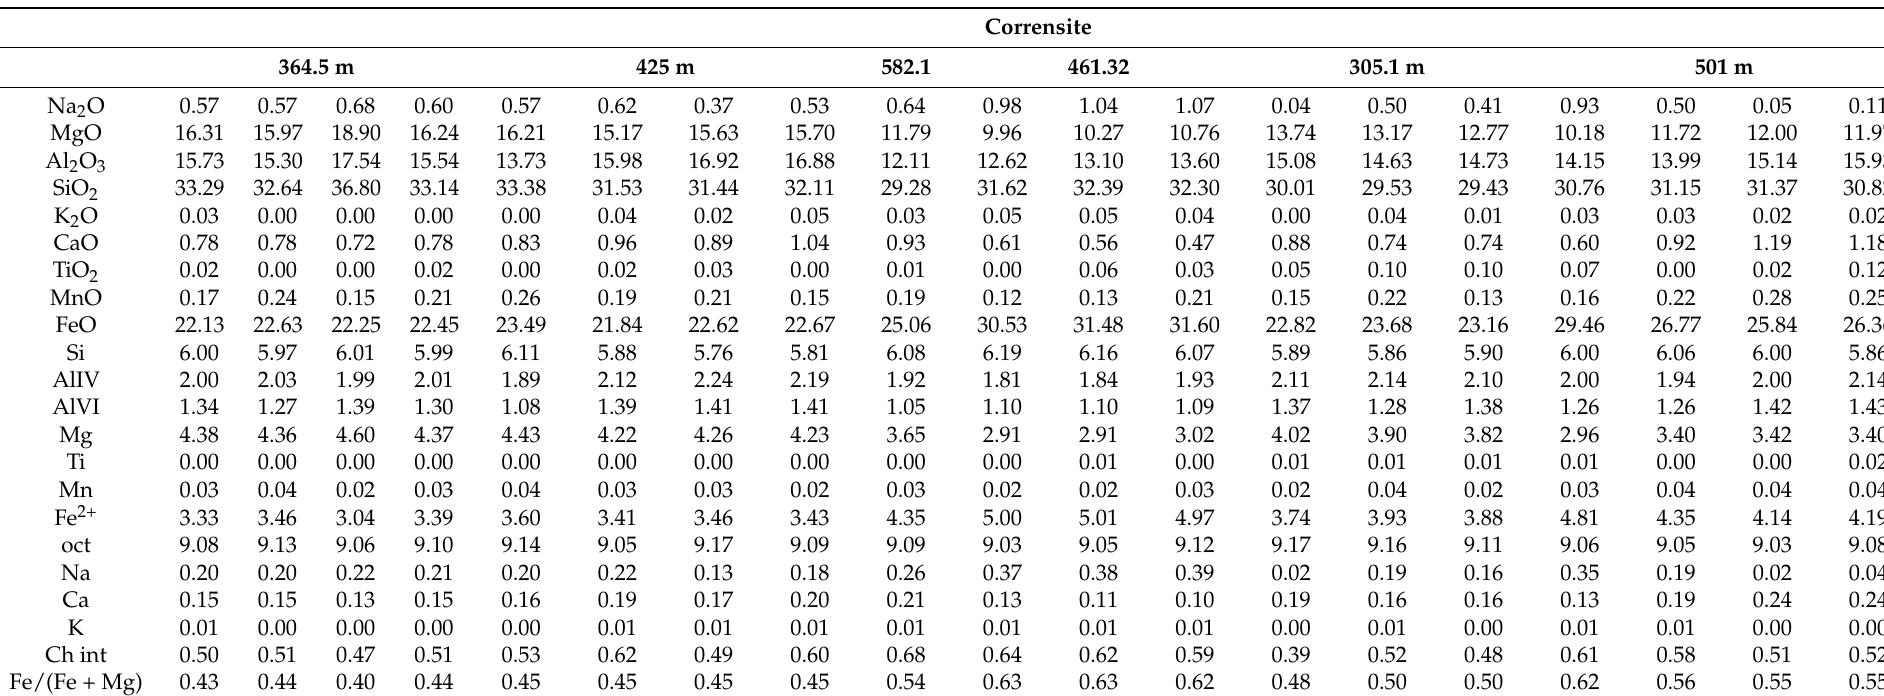
Table 2. Representative chemical compositions of corrensite. Structural formulas are calculated per half formula unit (25 oxygens). Analyses obtained by EDS on polished thin